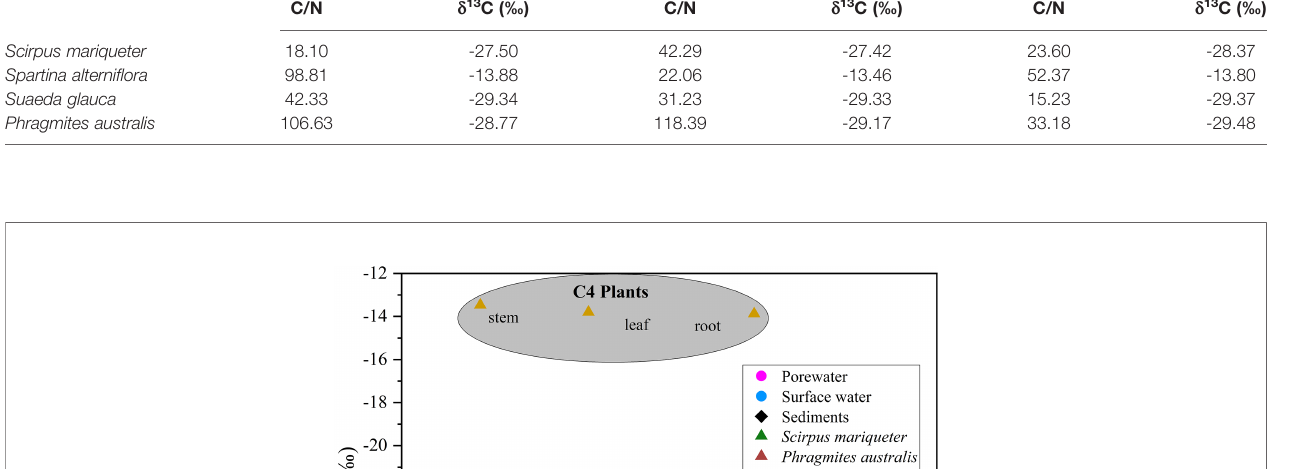
TABLE 3 | C/N molar ratio and d 13 C value of vegetations in Andong Shoal. Vegetations